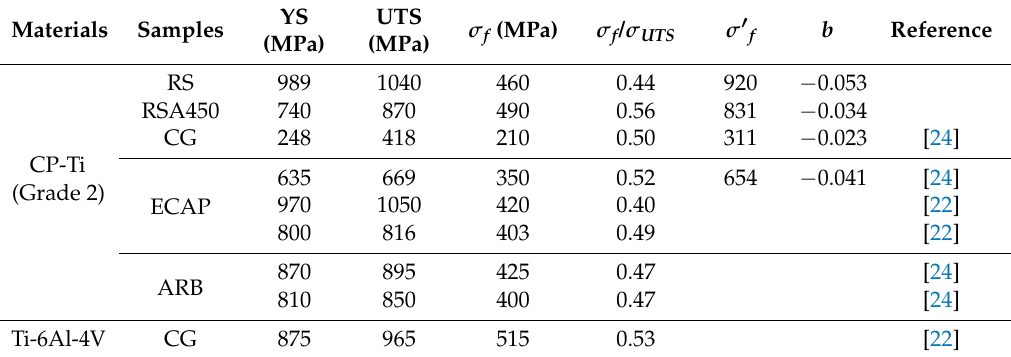
Figure 2. ( a ) Dependence of the fatigue life ( N f ) on the cyclic maximum stress for RS and RSA450 samples; ( b ) tensile strength versus fatigue ratio for experimental data of CP-Ti grade 2 and data in the literature and Ti-6Al-4V alloy. Table 2. Tensile and fatigue properties of RS samples, in comparison with those of the CG samples in CG states from references [22,24].